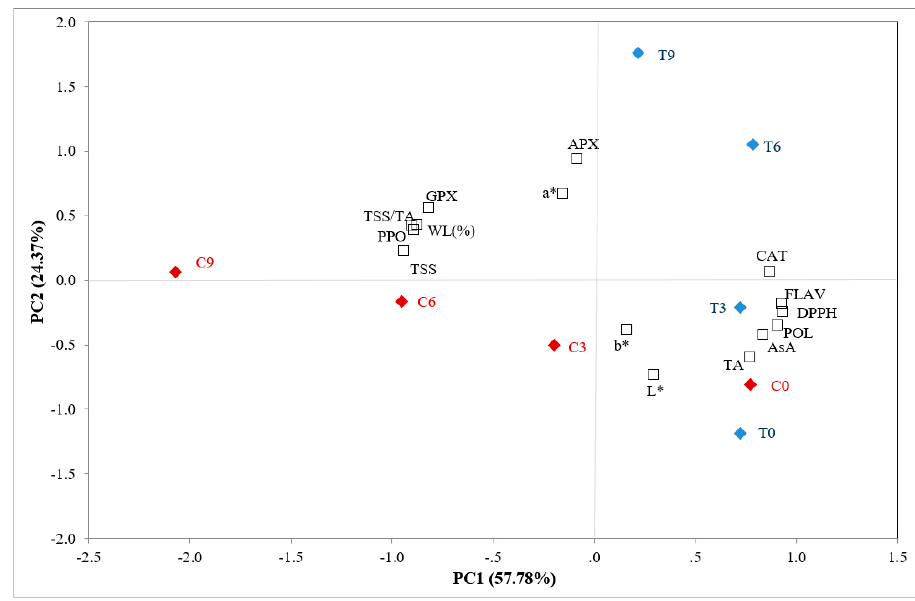
Figure 3. Two-dimensional principal component analysis of the physico-chemical and nutritional traits, and antioxidant enzyme activities during cold storage, at harvest (0), after three days (3), six days (6), and nine days (9) for uncoated (C) and chitosan-coated (T) fruits. (WL = weight loss; TSS = total soluble solid content; TA = titratable acidity; TSS/TA = ratio between total soluble solid content and titratable acidity; L*, a*, b* = colorimetric parameters; POL = polyphenol; FLAV = flavonoid; AsA = ascorbic acid content; DPPH = antioxidant activity; APX = ascorbate peroxidase; CAT = catalase; GPX = guaiacol peroxidase; PPO = polyphenol oxidase).